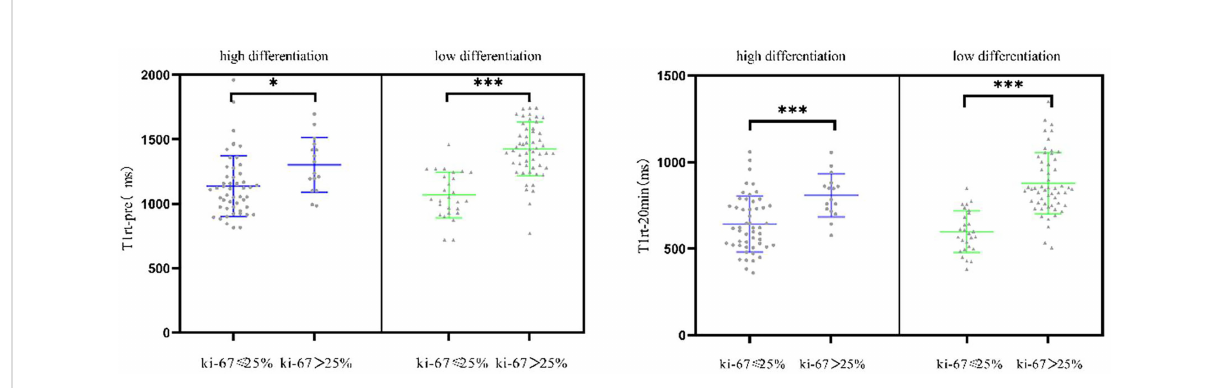
FIGURE 5 Correlation between the quantitative parameters of T1 mapping with Ki-67 expression in different histological differentiation patients (*<0.05;